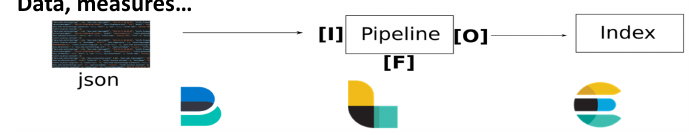
Figure 4. Schematic representation of generic ingestion